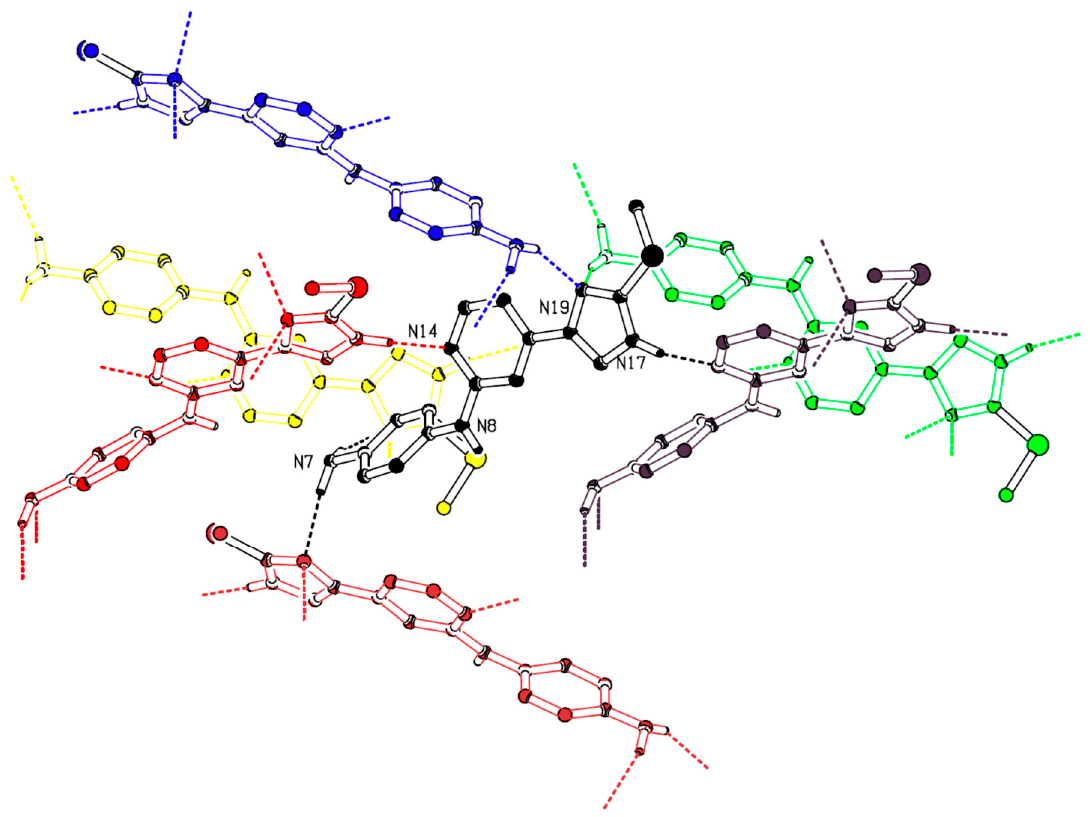
Figure 3. Partial packing diagram of 2 . Intermolecular hydrogen bonds are indicated as dashed lines.